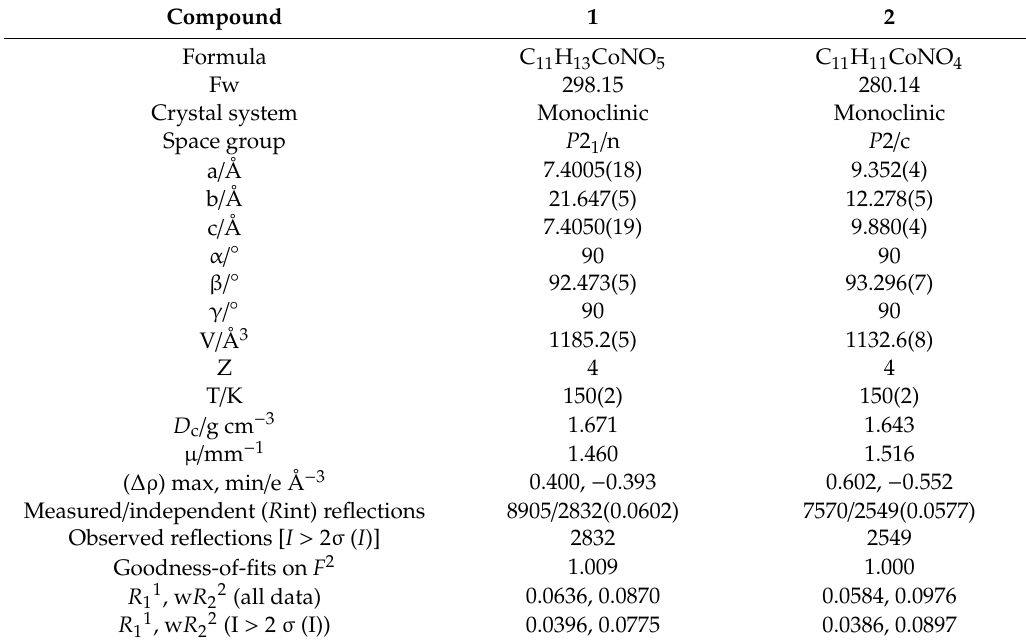
Table 1. The Crystallographic data for compounds 1 and 2